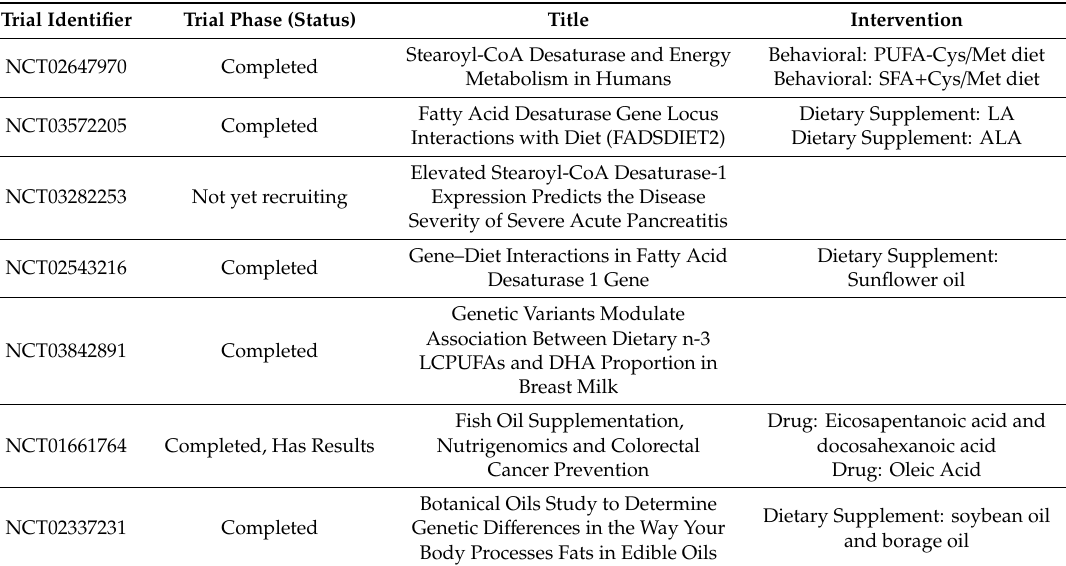
Table 1. Stearoyl-CoA desaturase 1 (SCD1) clinical